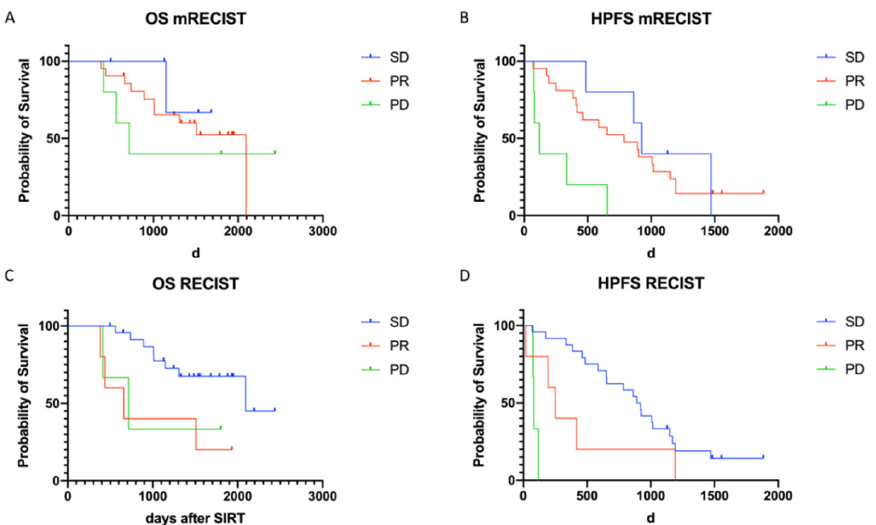
Figure 5. Kaplan–Meier curves of OS and HPFS of response groups by RECIST 1.1 ( C , D ) and mRECIST ( A , B ). According to RECIST, 1.1 patients classified as PR tended to have shorter HPFS